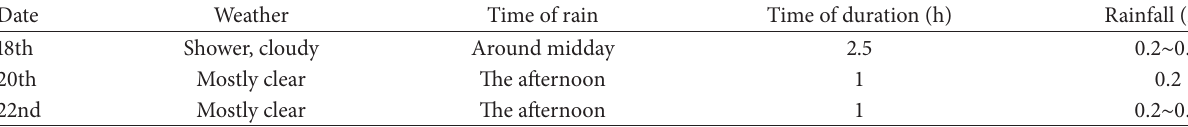
Table 1: Precipitation features from July 18th to 22nd, 2013.